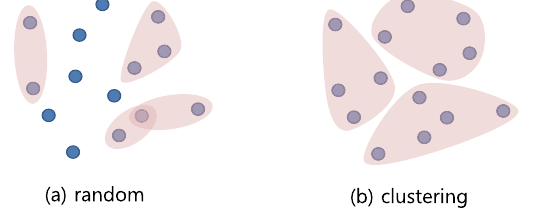
Figure 1. Typical group formations.